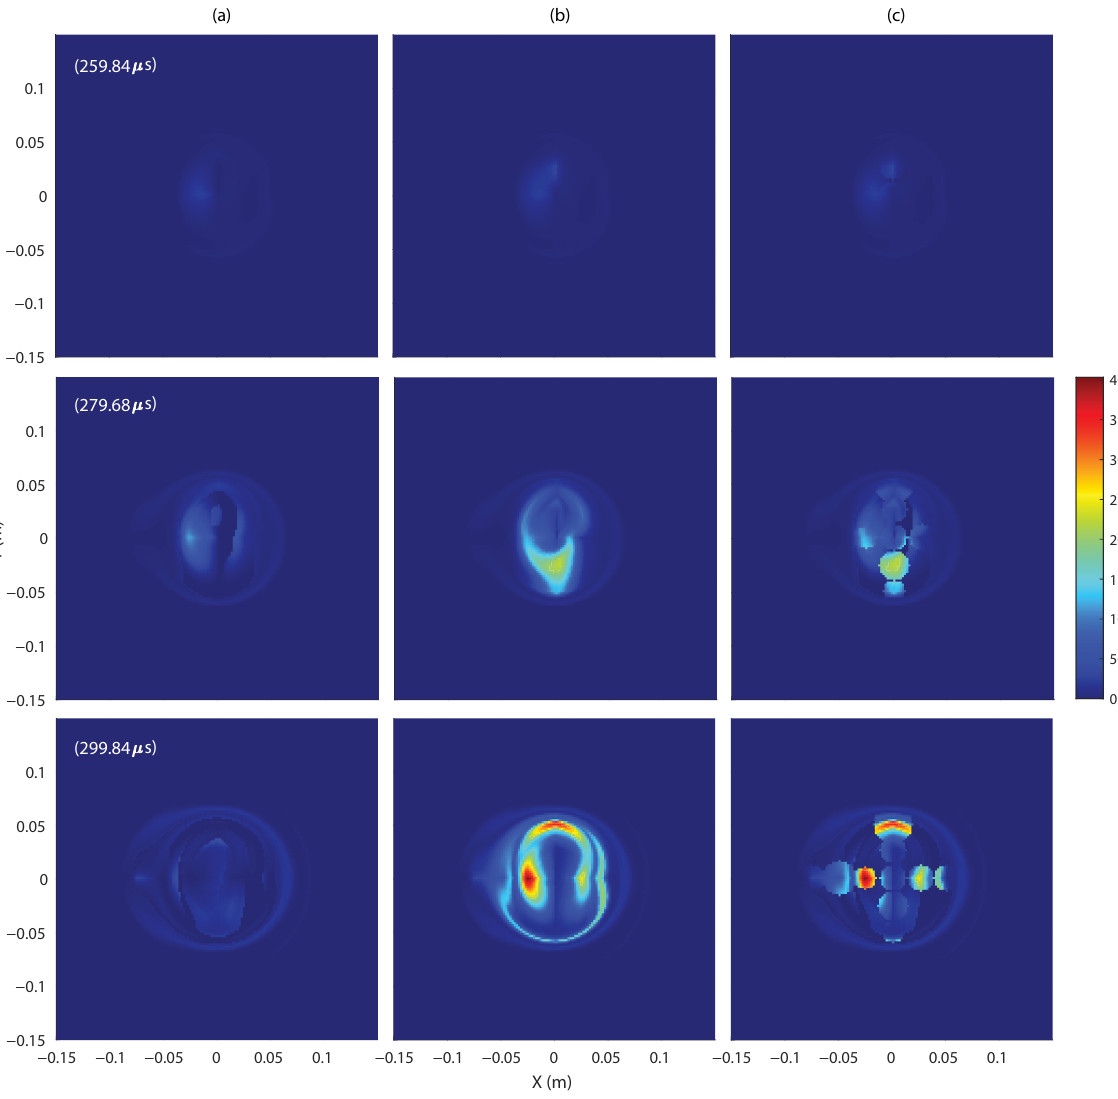
Figure 14. Test 34 (Stanag) pressure surfaces over a 40 µs period: ( a ) Background (strikes removed), ( b ) Original (skewed by particle strikes), and ( c )